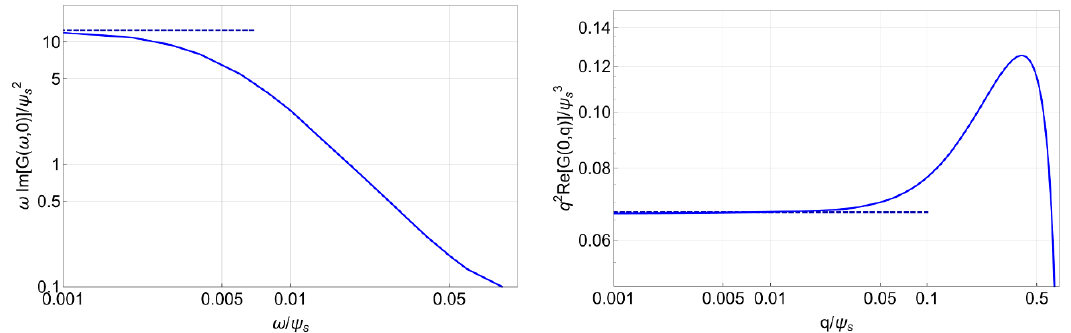
Figure 3 . We compare the analytic (dashed) and the numerical (solid) results for the two point functions G ( !; 0) and G (0 ; q ) as a function of the frequency and the